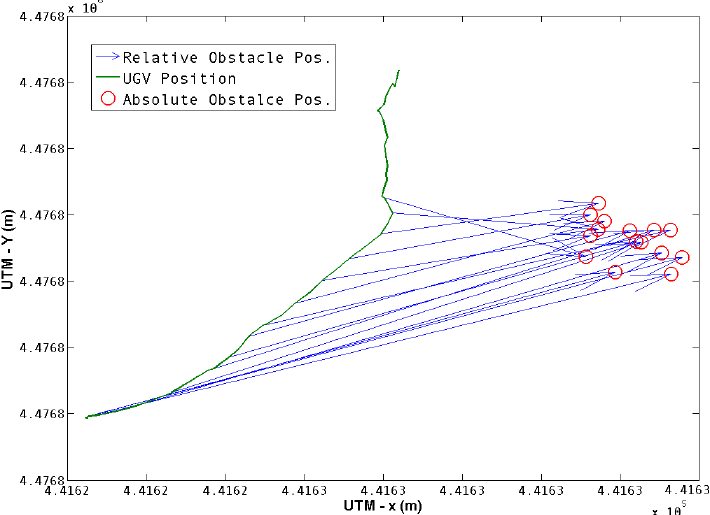
Figure 8. Obstacle Position Estimation. The green line denotes the UGV position. The blue arrows determine the transformation from each robot position to the center of the obstacle marked with red